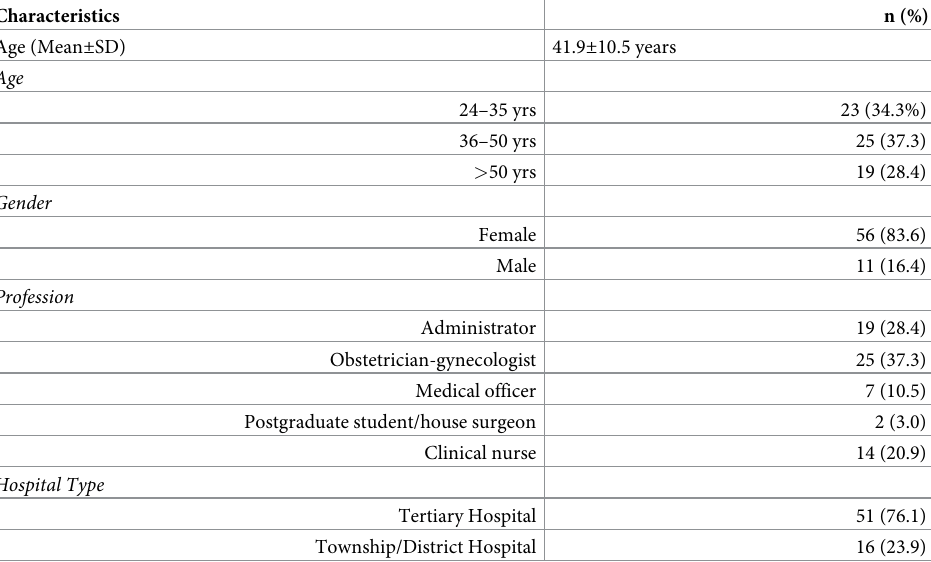
Table 1. Characteristics of the respondents (n =